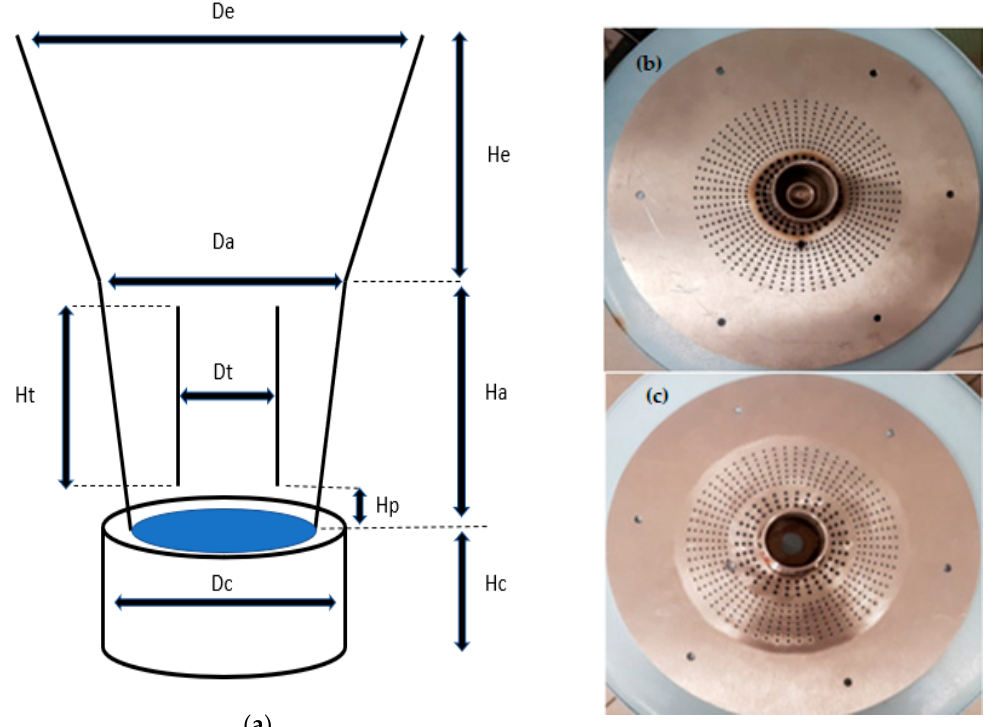
Figure 2. Schematic diagram of Wurster fluidized bed; ( a ) plexiglass expansion and annular chambers and stainless steel cylindrical chamber; ( b ) perforated plate design for narrow Wurster tube (diameter: 8 cm), ( c ) perforated plate design for wide Wurster tube (diameter: 10 cm), larger holes (diameter: 3.5 mm) under the tube zone and smaller holes (diameter: 2 mm) under the annular zone. The annular chamber, perforated plate and cylindrical chamber were connected via a